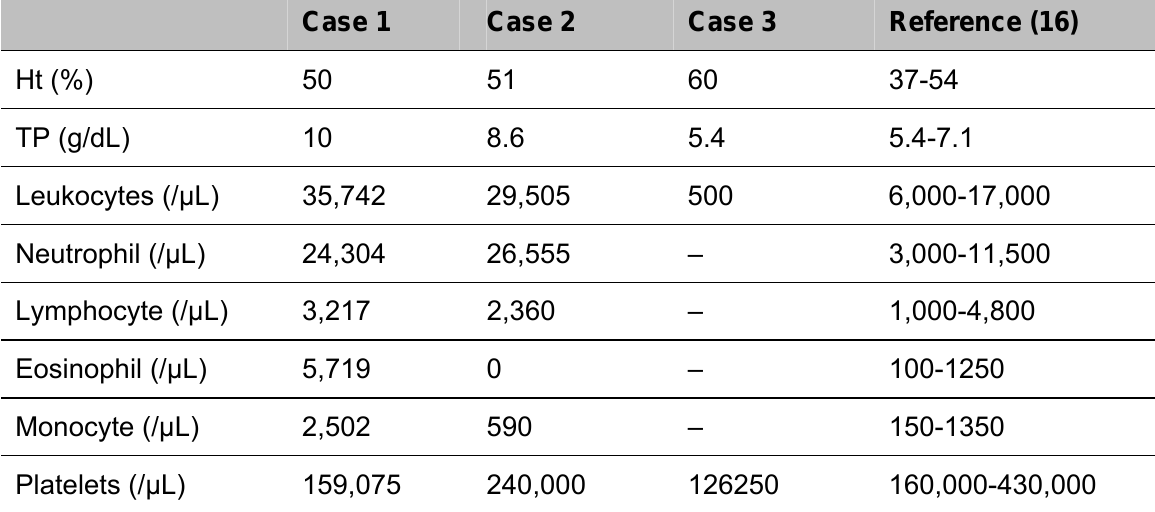
Figure 1. Ventricular tachycardia and respiratory sinus arrhythmia in a male dog poisoned by bufotoxin. Table 1. Hematological findings in the three dogs poisoned by